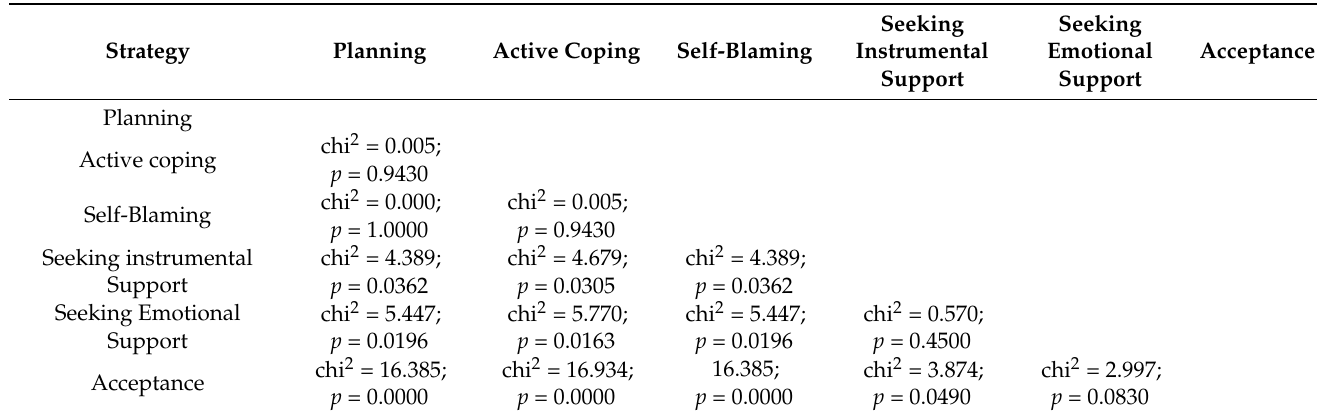
Table A2. Levels of statistical significance for post hoc pairwise comparisons of stress-coping strate- gies chosen in population presenting awake bruxism symptoms.